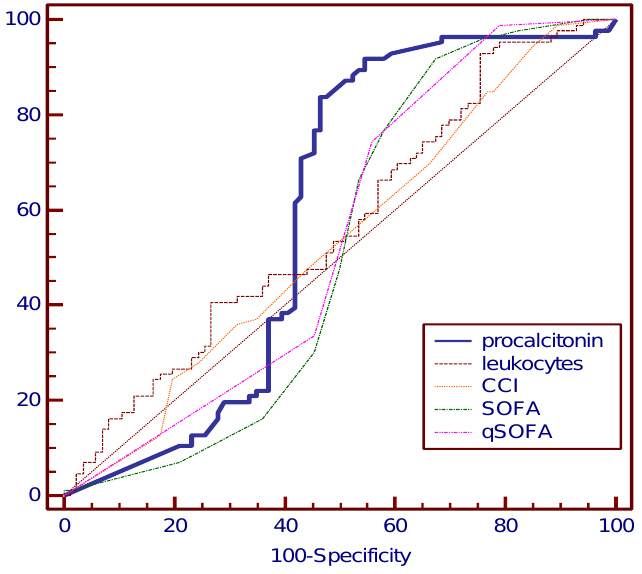
Figure 3. Pairwise comparison of ROC curves for the sepsis group. In the case of the septic shock group, as expected, qSOFA (specificity 92.5%, sensitivity 82.71%), SOFA (specificity 97.5%, sensitivity 77.44%), and PCT (specificity 80%, sensitivity 85.61%) were statistically significant disease-defining variables (Figure 4, Table 2), the best AUC value being for the SOFA score